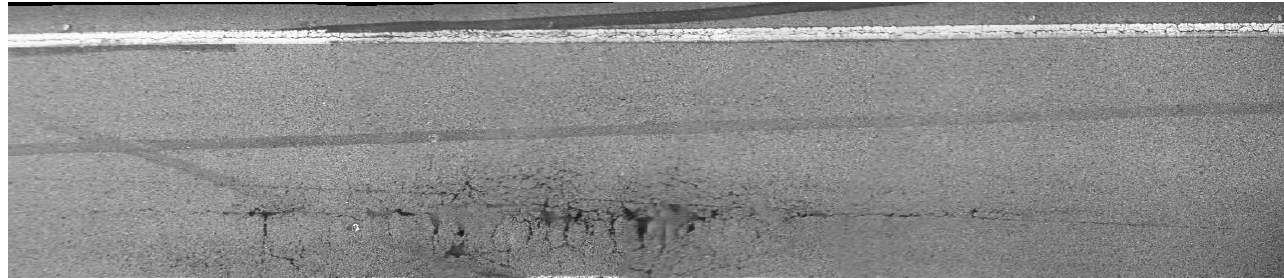
Figure 13. Sample of a road lane section.